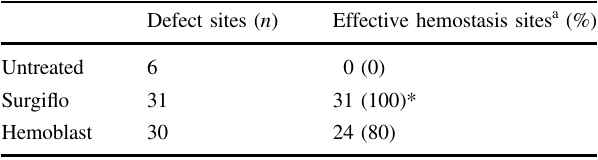
Table 2 Number of defect sites that achieved effective